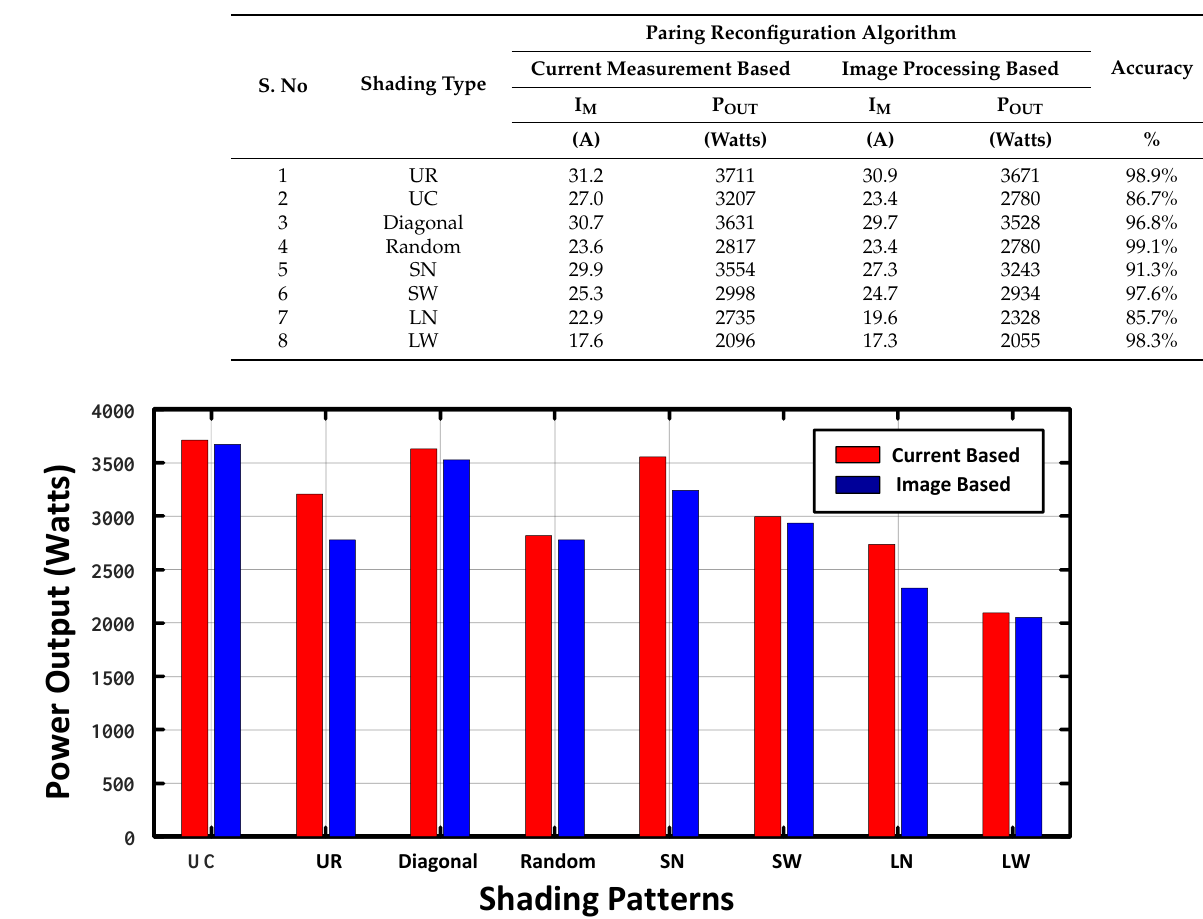
Table 8. Output power of image processing-based reconfiguration.